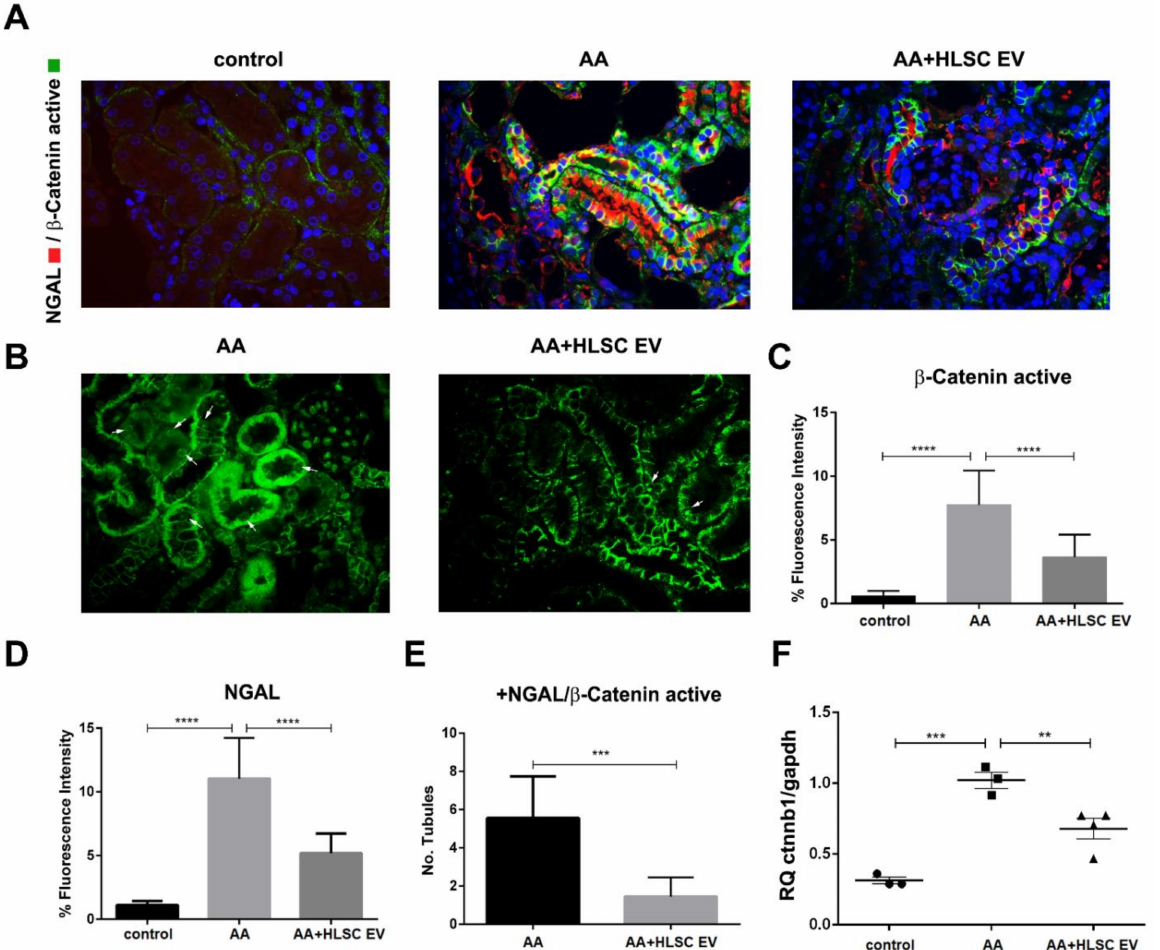
Figure 3. Active β -catenin and NGAL are downregulated by HLSC-EVs in AAN. ( A ) Representative immunofluorescence images show increased expression of active β -catenin and NGAL in AAN mice, which are downregulated following treatment with HLSC-EVs (AA and AA+HLSC EV) (magnification 400 × ). ( B ) The white arrows show nuclear localisation of β -catenin active in AA and AA+HLSC EV experimental groups (magnification 400 × ). ( C ) Histogram depicting the percentage fluorescence intensity of β -catenin active and NGAL ( D ) in the experimental groups. Data represent mean ± SD of the fluorescence intensity measured from 10 images per high power field taken at random ( C , D ) (n = 5 mice per group). **** p < 0.0001 AA vs. control and AA+HLSC EV vs. AA. ( E ) the number of tubules positive for colocalisation of NGAL and β -catenin active in AA and AA+HLSC EV experimental groups. Data represent mean ± SD of the number of tubules counted from 10 images per high power field taken at random (n = 5 mice per group). *** p < 0.001 AA+HLSC EV vs. AA. ( F ) Gene expression level of Ctnnb1 in kidney tissue from AAN mice experimental groups. ** p < 0.01, *** p < 0.001 AA vs. control and AA vs. AA+HLSC EV. (n = 3 mice for control and AA, and n = 4 mice for AA+HLSC EV) RQ – relative quantity of Ctnnb1 gene vs. housekeeping Gapdh